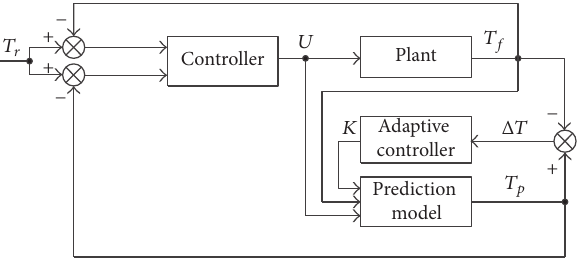
Figure 3: Block diagram of adaptive control